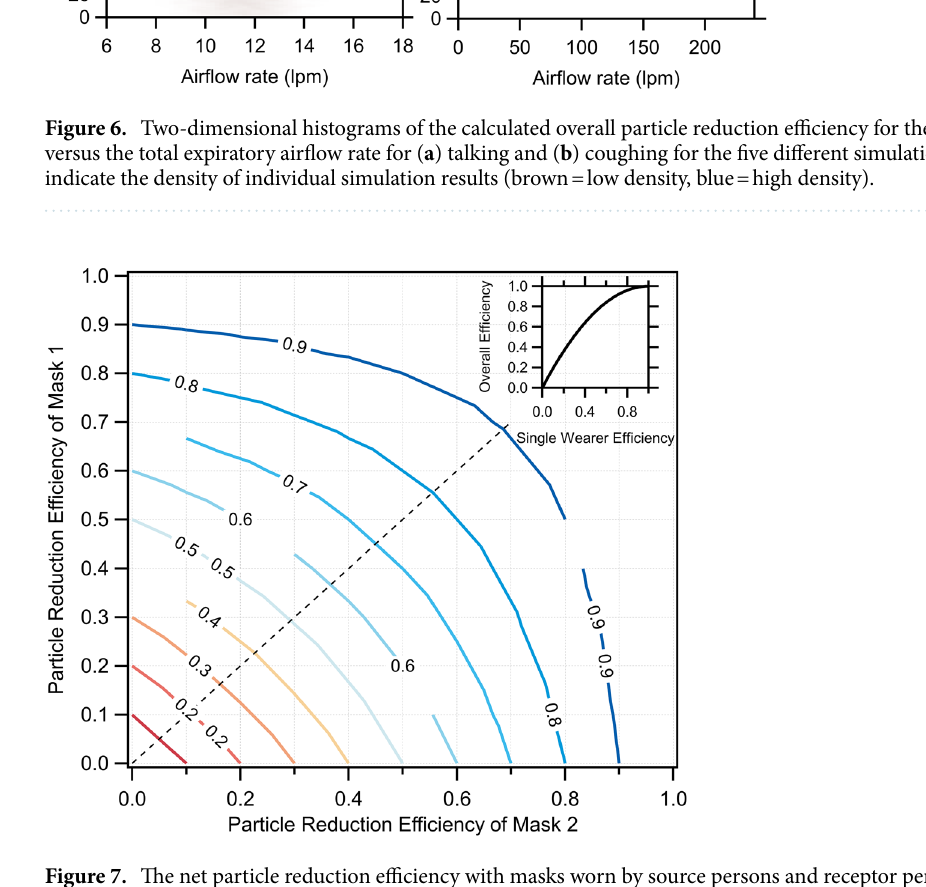
Figure 7. The net particle reduction efficiency with masks worn by source persons and receptor persons, for the wearer masks having varying efficiency. (Inset) The overall reduction efficiency versus single mask reduction efficiency assuming the same mask efficiency for the source person and receptor